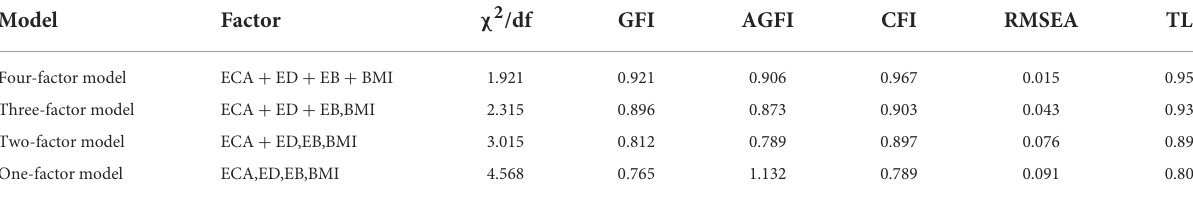
TABLE 1 The result of confirmatory factor analyses.